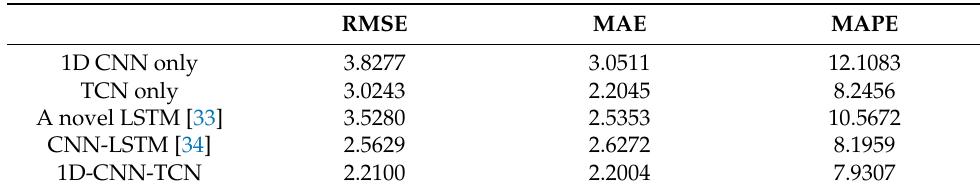
Table 5. The proposed 1D-CNN-TCN prediction model is compared with related models. The table shows the evaluation results of the 1D-CNN-TCN, 1D CNN, and TCN ablation experiments using RMSE, MAE, and MAPE, and the evaluation results of 1D-CNN-TCN compared with a novel LSTM [33] and CNN-LSTM [34] using RMSE, MAE, and MAPE. RMSE MAE MAPE 1D CNN